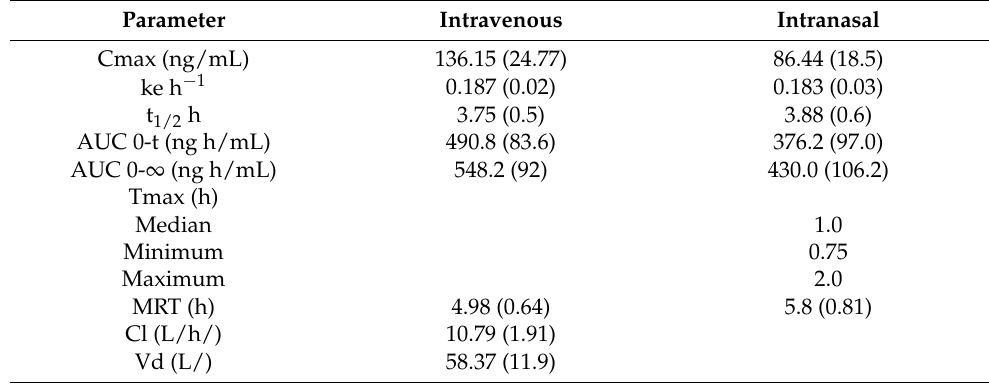
Table 3. Mean pharmacokinetic parameters (sd) for DXM after intravenous and intranasal administration.